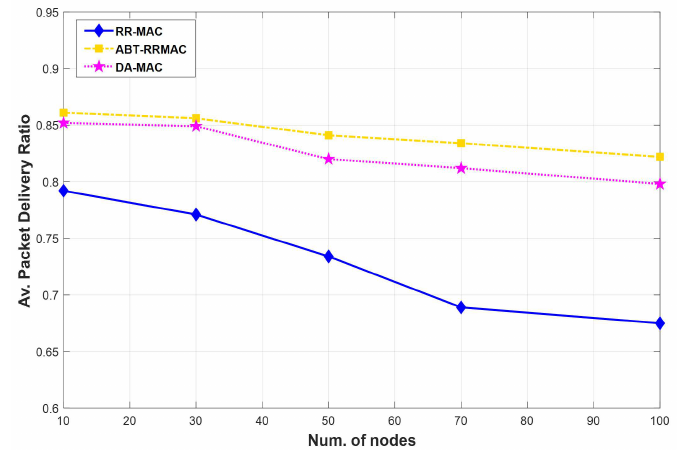
Figure 12. PDR-considered